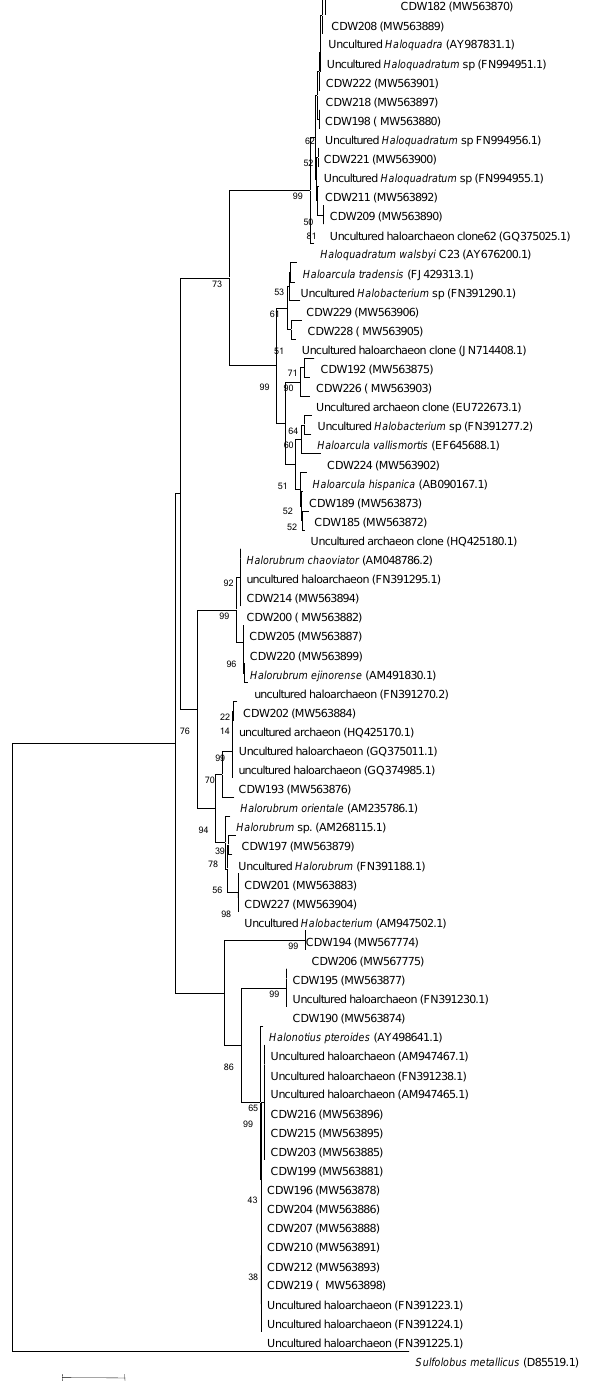
Figure 5. Neighbor-joining tree showing relationships among CDW clones’ and their closest rela- tives retrieved from RDPII database. Evolutionary distances were calculated using the method of maximum composite likelihood and the topology was inferred using the neighbor-joining method using MEGA 6 software. Numbers on the nodes present % bootstrap values based on 1000 replicates. Scale bar represents 0.05 substitutions per site. The 16S rRNA gene sequence of Sulfolobus metallicus was arbitrarily chosen as the outgroup to define the root of the tree. Accession number of sequences are shown in